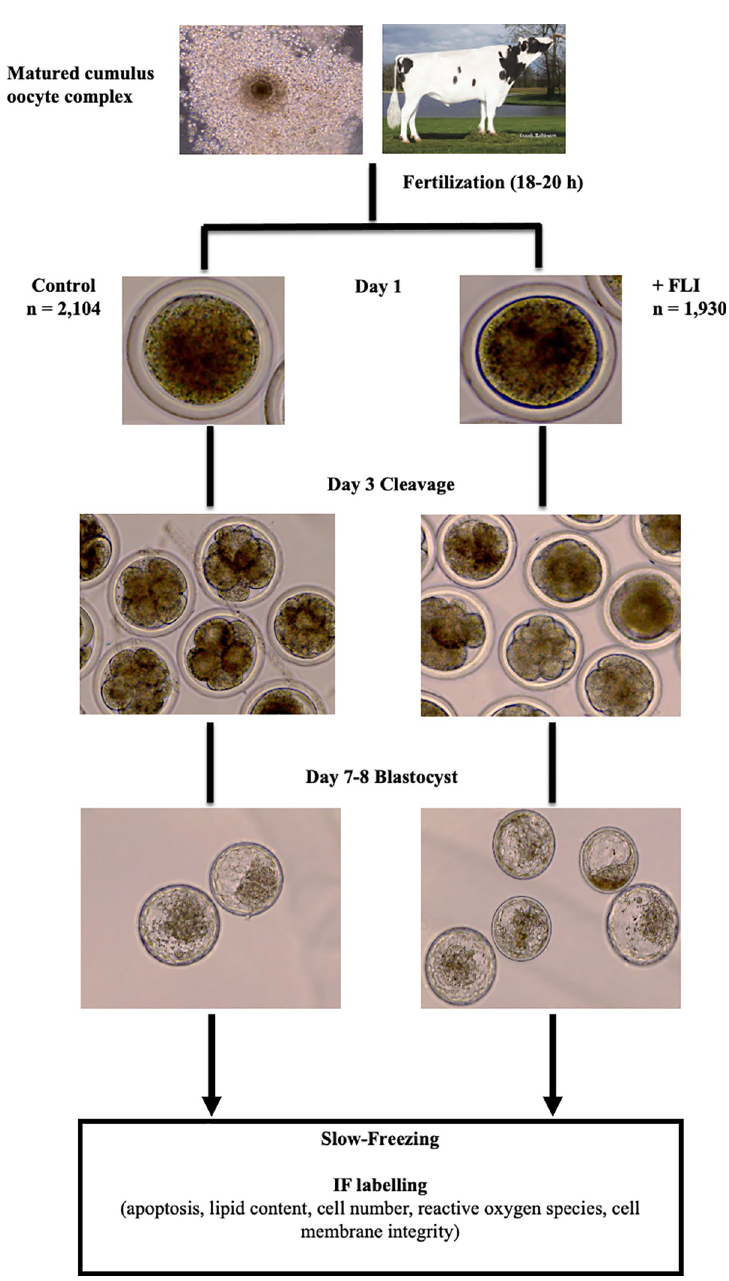
Fig 2. Experimental setup of FLI supplemented to embryo culture medium. Cumulus oocyte complexes (COCs) were matured in oocyte maturation medium (OMM). Following fertilization, putative zygotes were placed in culture with (n = 1,930) or without (n = 2,104) FLI. FLI was supplemented at the dosage of FGF2 (40ng/ml), LIF (20ng/ml), and IGF1 (20ng/ml). Cleavage (at least one cellular division) was recorded on day 3 and development to the blastocyst stage was recorded on day 7 and 8. Day 7 or 8, blastocyst stage embryos were either collected for cell counting, quantification of lipid content, membrane integrity analysis, quantification of reactive oxygen species, or slow frozen, and subjected to TUNEL assay to analyze apoptosis, membrane integrity analysis, or quantification of reactive oxygen species post-thaw. IF = immunofluorescent labeling.